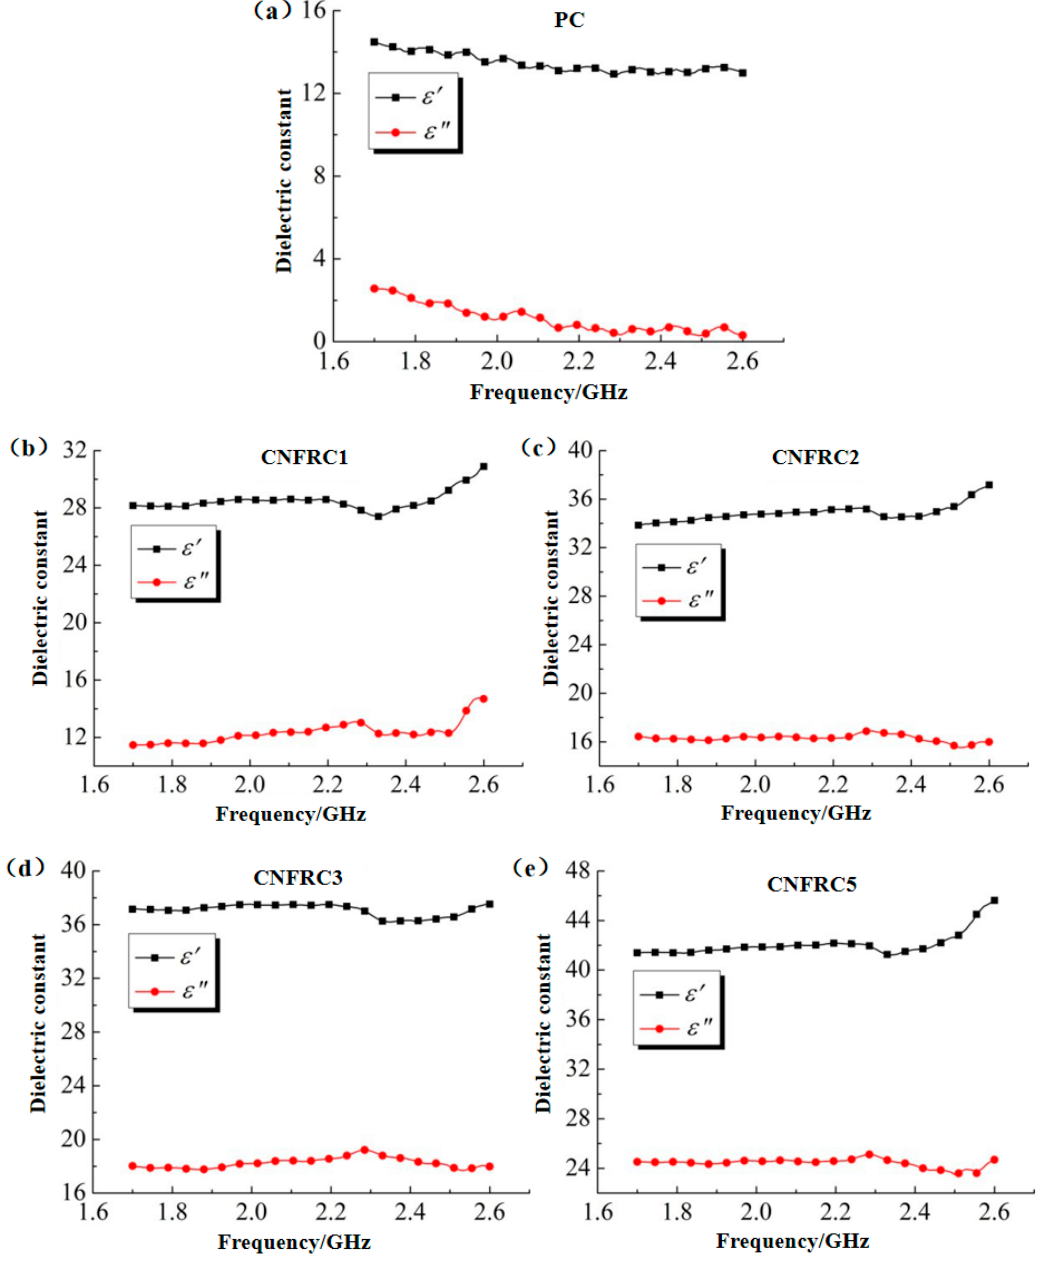
Figure 6. Dielectric constants of cement mortar for groups. ( a ) PC; ( b ) CNFRC1; ( c ) CNFRC2; ( d ) CNFRC3; ( e ) CNFRC5.